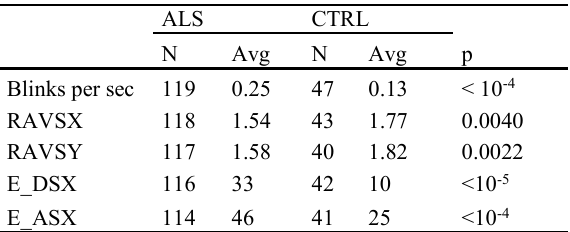
Table 2. Oculomotor executive scores and frequency of eye lid blinks in ALS patients and controls.